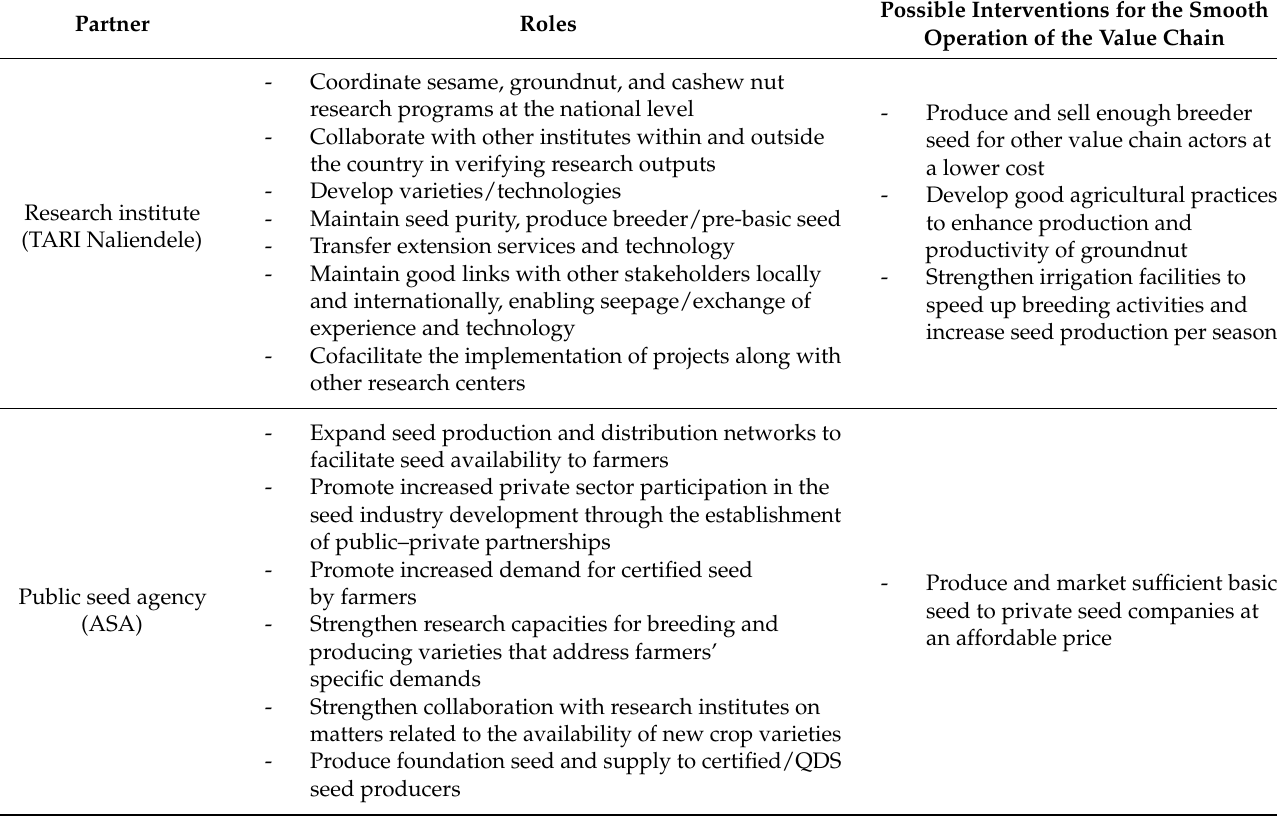
Table 2. Public, private, and other development organization partner